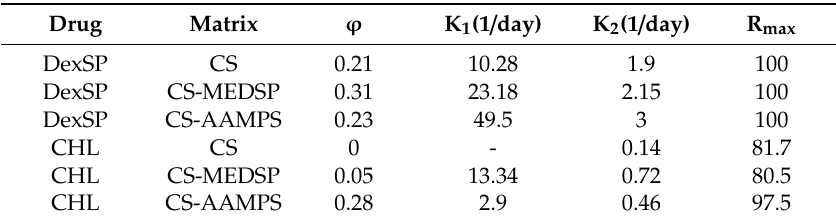
Table 4. Parameter values for fitting the experimental release data using Equation (4).